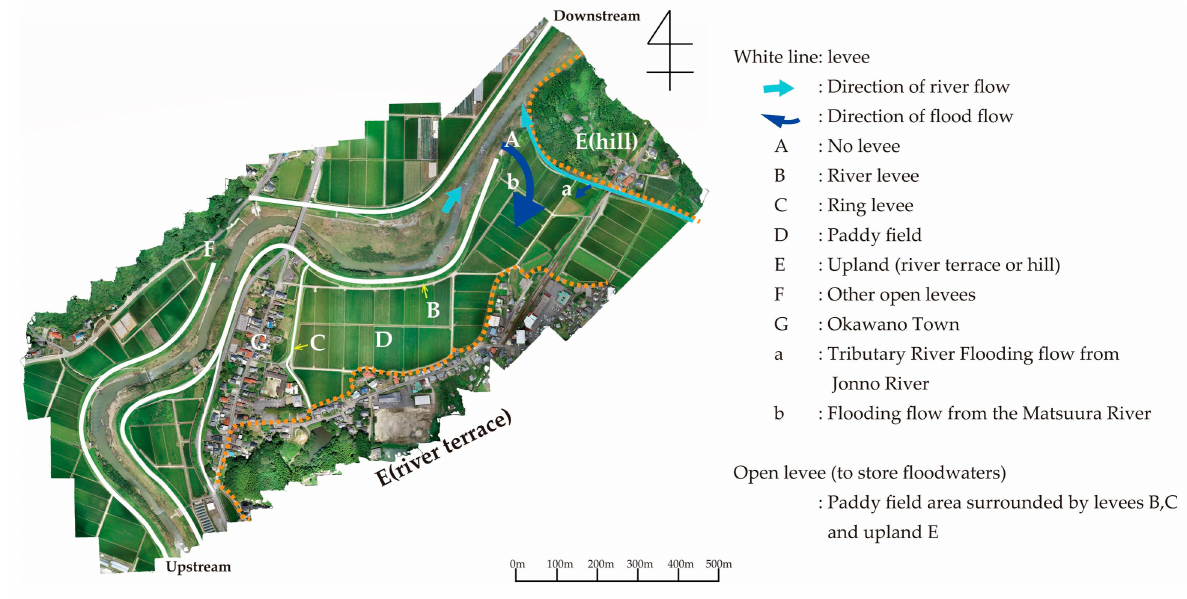
Figure 3. Okawano ortho image and